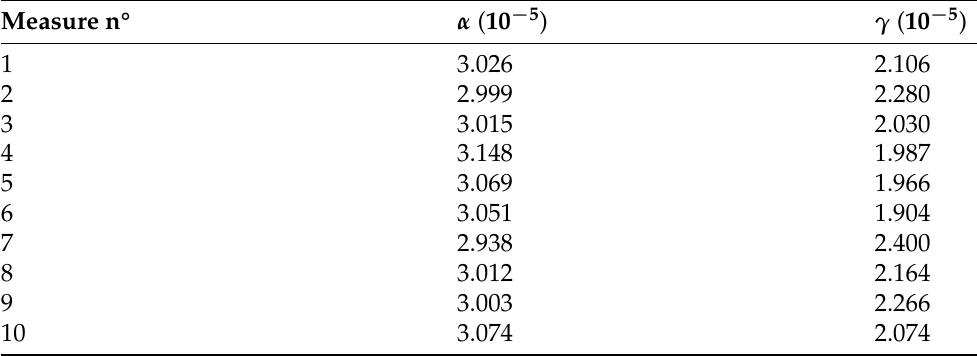
Table 2. Extracted coefficients α , γ using (3) for the resonator with no nanowires. Measure